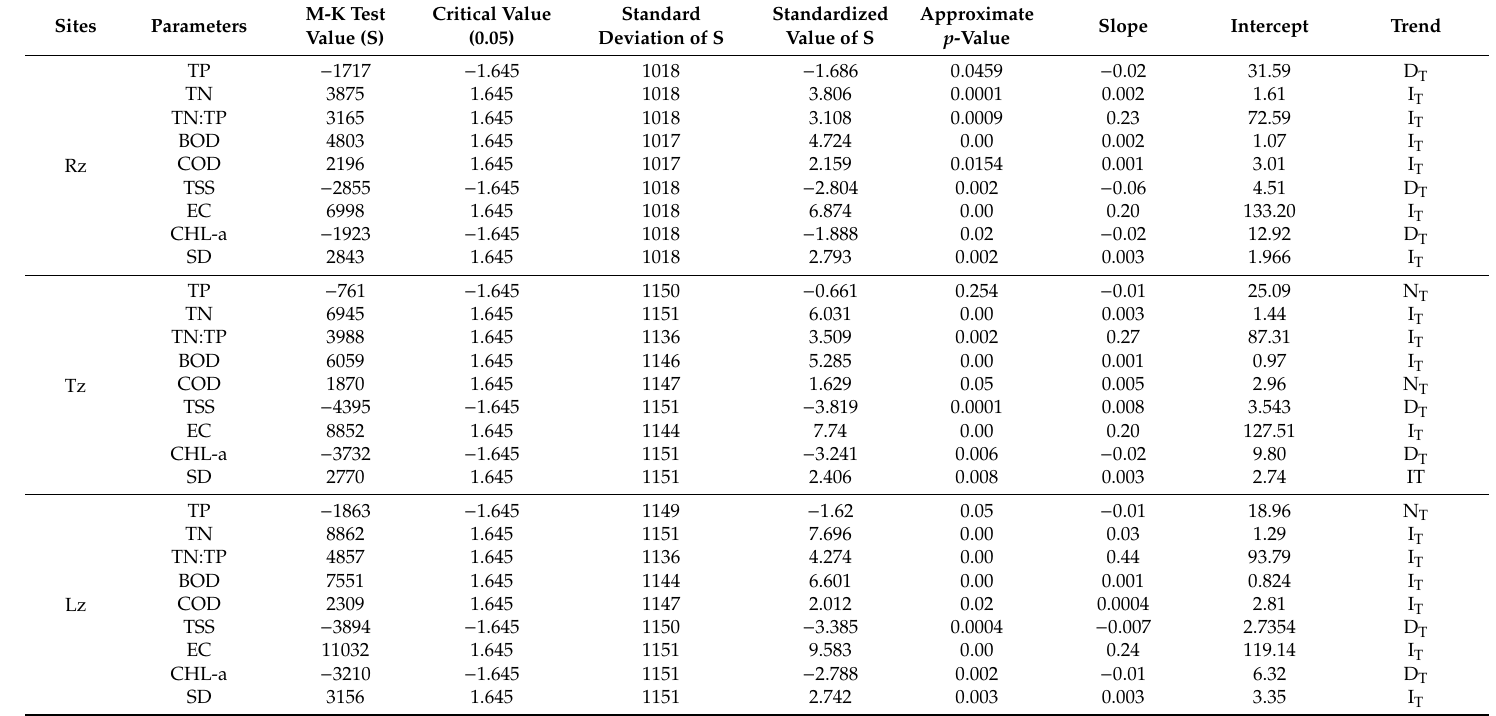
Table 3. Long-term trend analysis of water quality parameters in the Daecheong Reservoir during 2000–2018 (TP: total phosphorus, TN: total nitrogen, BOD: biological oxygen demand, COD: chemical oxygen demand, TSS: total suspended solids, EC: electrical conductivity, CHL-a: chlorophyll-a, SD: Secchi depth, Rz: riverine zone, Tz: transitional zone, Lz: lacustrine zone, IT1: drinking water intake tower 1, IT2: drinking water intake tower 2, D T : decreasing trend, I T : increasing trend, N T : no trend, monthly data from 2000–2018 were used to see the trend of water quality parameters separately from Rz to